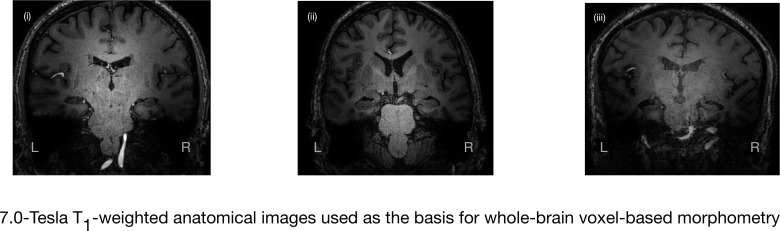
7.0-Tesla whole-brain anatomical magnetic resonance imaging.Whole-brain 7.0-Tesla T1-weighted anatomical (600 µm isotropic spatial resolution) coronal images from three participants in the amnesic group (i–iii), illustrating significant in vivo volume loss in the hippocampus. T1-weighted anatomical images from participants in the amnesic and control groups were used to conduct whole-brain voxel-based morphometry (VBM). The 7.0-Tesla T1-weighted anatomical images are a subgroup re-analysis of those reported in our previous clinical study involving 18 participants at the chronic phase of the LGI1-antibody-complex LE phenotype (Miller et al., 2017). Normalized gray matter in the amnesic group and in the control group participants, derived from the whole-brain VBM analysis, were contrasted using a two-sample t-test and thresholded at p<0.05 family-wise error corrected for multiple comparisons with SPM12. No evidence of significant gray matter volume loss was found outside of the hippocampus in the amnesic group relative to the control group (see ‘Results’ section), which is in agreement with the results from VBM reported in our previous study (Miller et al., 2017). Adapted from Miller et al. (2017), published under CC BY license, http://creativecommons.org/licenses/by/4.0/.